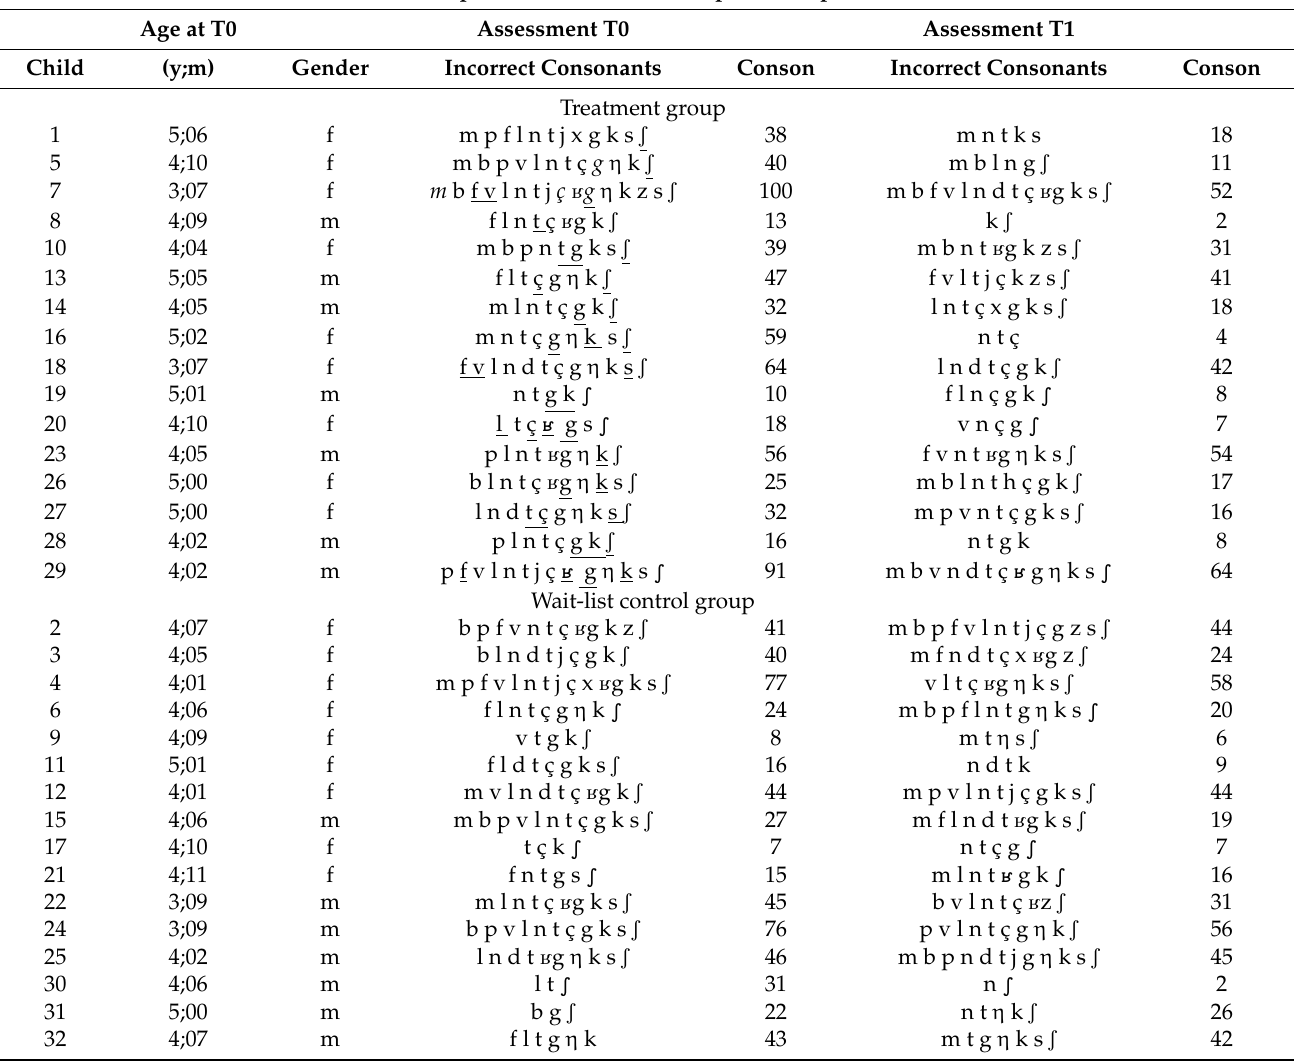
Table 2. The columns “incorrect consonants” list the mispronounced consonants; consonants mispronounced at least twice are written in bold; consonants treated from T0 to T1 are underlined; the columns “Conson” show the total number of mispronounced consonants and consonant